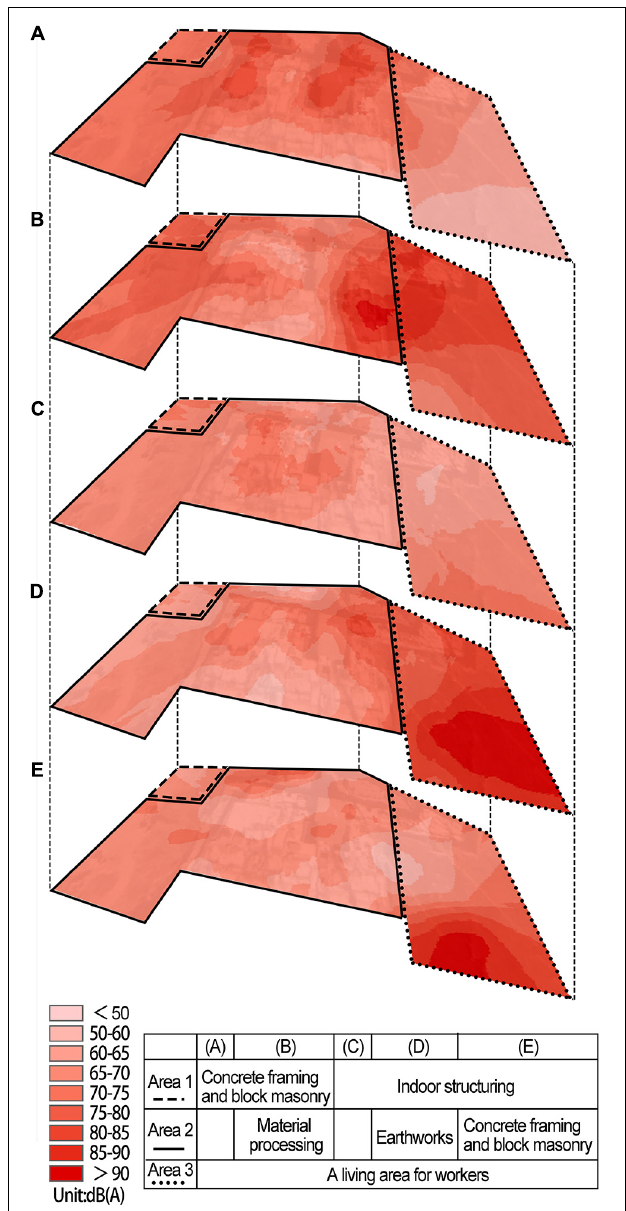
FIGURE 3 | Noise levels of different construction stages: (A) 26th Apr, 2019; (B) 19th Jun, 2019; (C) 22th Aug, 2019; (D) 20th Sep, 2019; (E) 19th Oct,